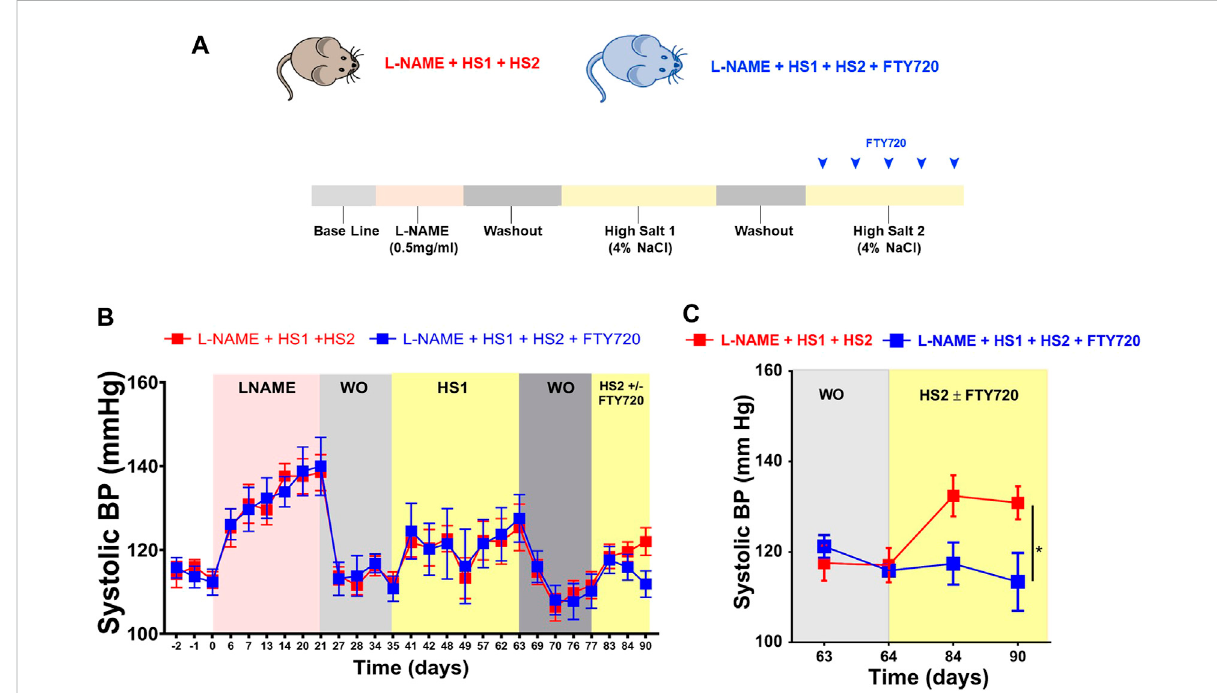
FIGURE 1 Fingolimod protects the mice from developing hypertension after exposure to the same hypertensive stimulus (high salt diet). (A) Experimental paradigm: summary of the protocol followed describing the diet fed to the mice at each phase during the experiment. (B) Systolic blood pressure of consciousmicethatreceivedL-NAME+HS1+HS2± fi ngolimodwasmeasuredusingthenon-invasivetail-cuffmethod. (C) Systolicbloodpressureof consciousmicethatreceivedL-NAME+HS1+HS2± fi ngolimodwasmeasuredusingtheinvasiveradiotelemetrymethod.N=6 – 10mice/group. Results are presented as mean ± SEM. p -value calculated by 2-way Anova test. * p <